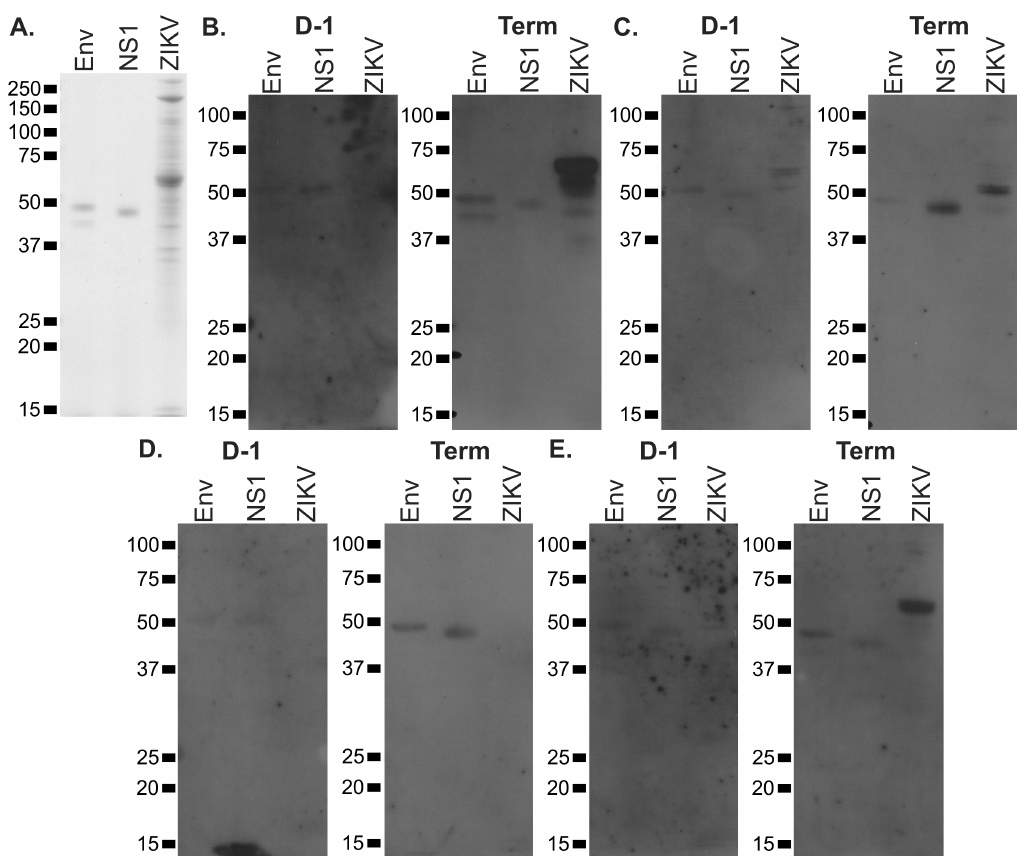
Fig 4. Anti-ZIKV antibody production by infected guinea pigs. To assess whetheran antibodyresponse to ZIKV proteins is elicitedin challengedguineapigs, purifiedZIKV Env and NS1 and semi-purified viral particles were resolved by SDS-PAGE, transferred to membranes, and immunoblotted. (A) Coomassie stained gel showingthe sizes of input protein. (B-E) Proteins were transferred to membranes and immunoblotted using plasma collectedfrom four ZIKV challengedpregnantguineapigs either the day before viral challenge(D-1) or the day of delivery